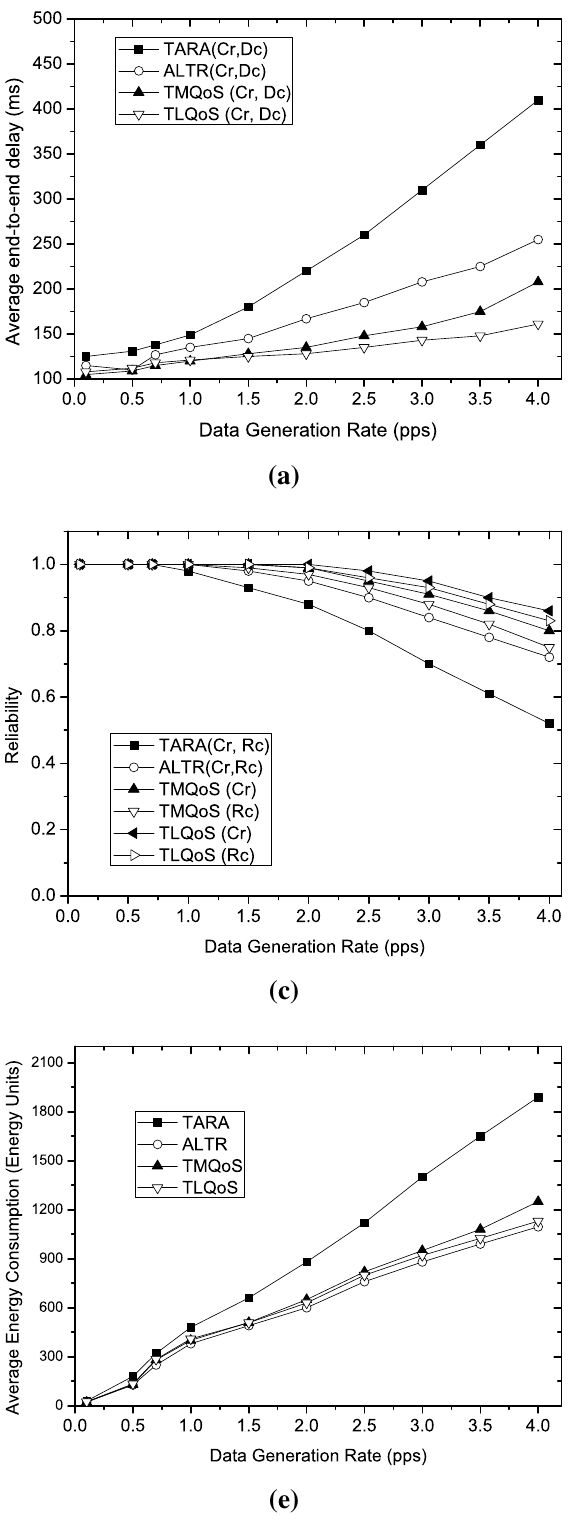
Figure 4. Performance Comparison for different traffic loads. ( a ) Average End-to-End delay varying data generation rate; ( b ) On Time Packet Packet Delivery Ratio varying data generation rate; ( c ) Reliability varying data generation rate; ( d ) Average Temperature Rise varying data generation rate; ( e ) Average Energy Consumption varying data generation